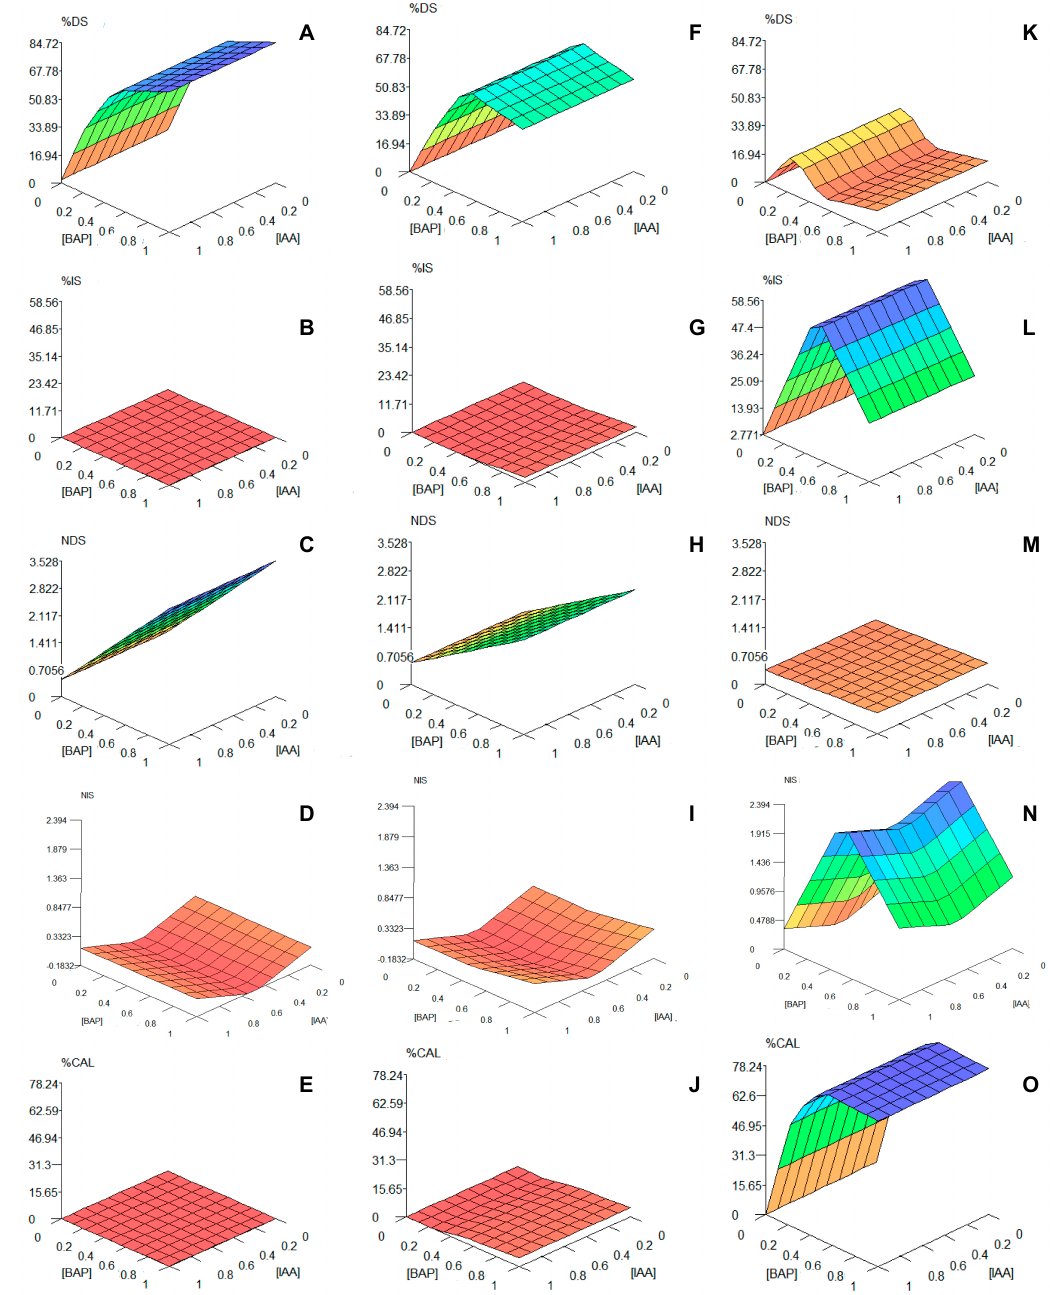
Figure 1. Graphical tridimensional extrapolation of the predictive models, generated for each output and genotype, by FormRules ® : ( A – E ) results for Bryophyllum × houghtonii (BH); ( F – J ) results for Bryophyllum daigremontianum (BD); ( K – O ) results for Bryophyllum tubiflorum (BT); ( A , F , K ) refer to percentage direct shoot regeneration (%DS); ( B , G , L ) refer to percentage indirect shoot regeneration (%IS); ( C , H , M ) refer to number of direct shoots (NDS); ( D , I , N ) refer to number of indirect shoots (NIS); ( E , J , O ) refer to percentage of callus formation (%CAL). BAP and IAA concentrations are expressed as mg L − 1